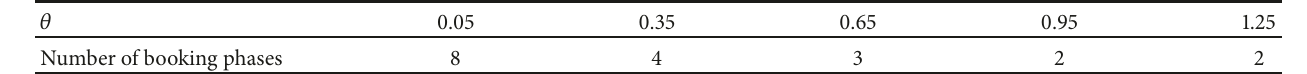
Table 6: Parameter 𝜃 and its corresponding number of partition booking